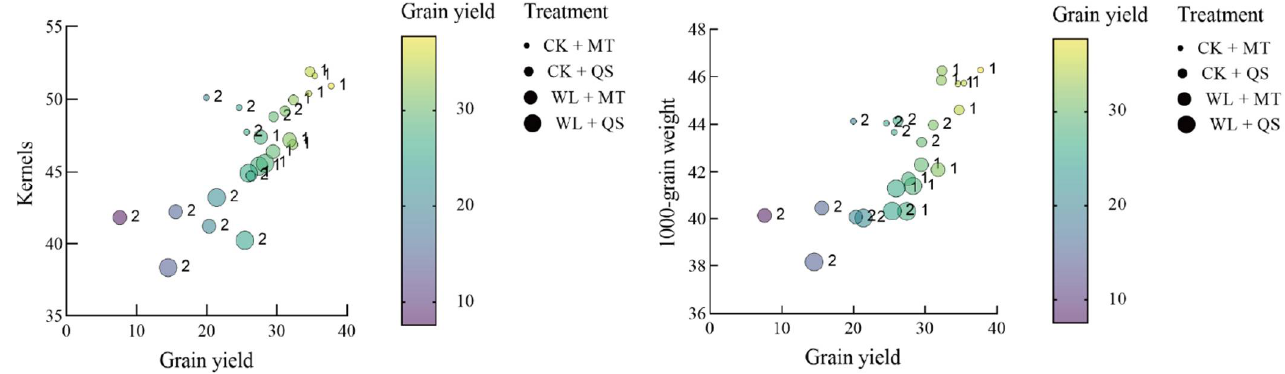
Figure 11. Using a bubble chart to analyze the effect of grain number and thousand-grain weight on yield by cultivar and treatment, i.e., CK + QS: leaf spraying with distilled water under non-waterlogged conditions; CK + MT: leaf spraying with 100 μmol·L −1 of melatonin under non-waterlogged conditions; WL + QS: leaf spraying with distilled water under waterlogged conditions; WL + MT: leaf spraying with 100 μmol·L −1 of melatonin under waterlogged conditions. 1 represents Yangmai 18, and 2 represents Yannong 19.